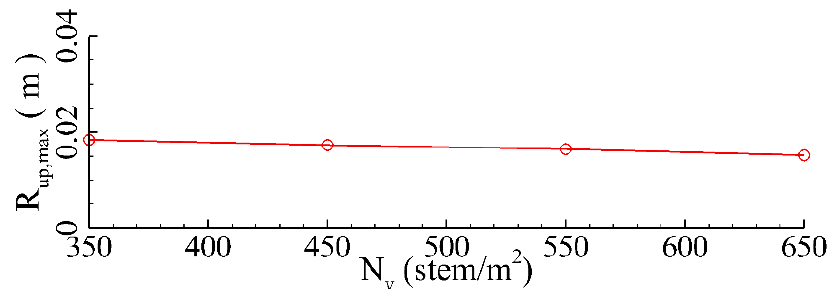
Figure 28. Maximum wave runup height under different vegetation densities.